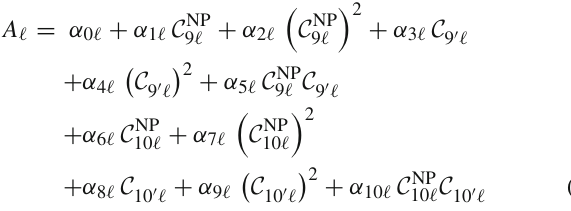
in the vicinity of the SM point K